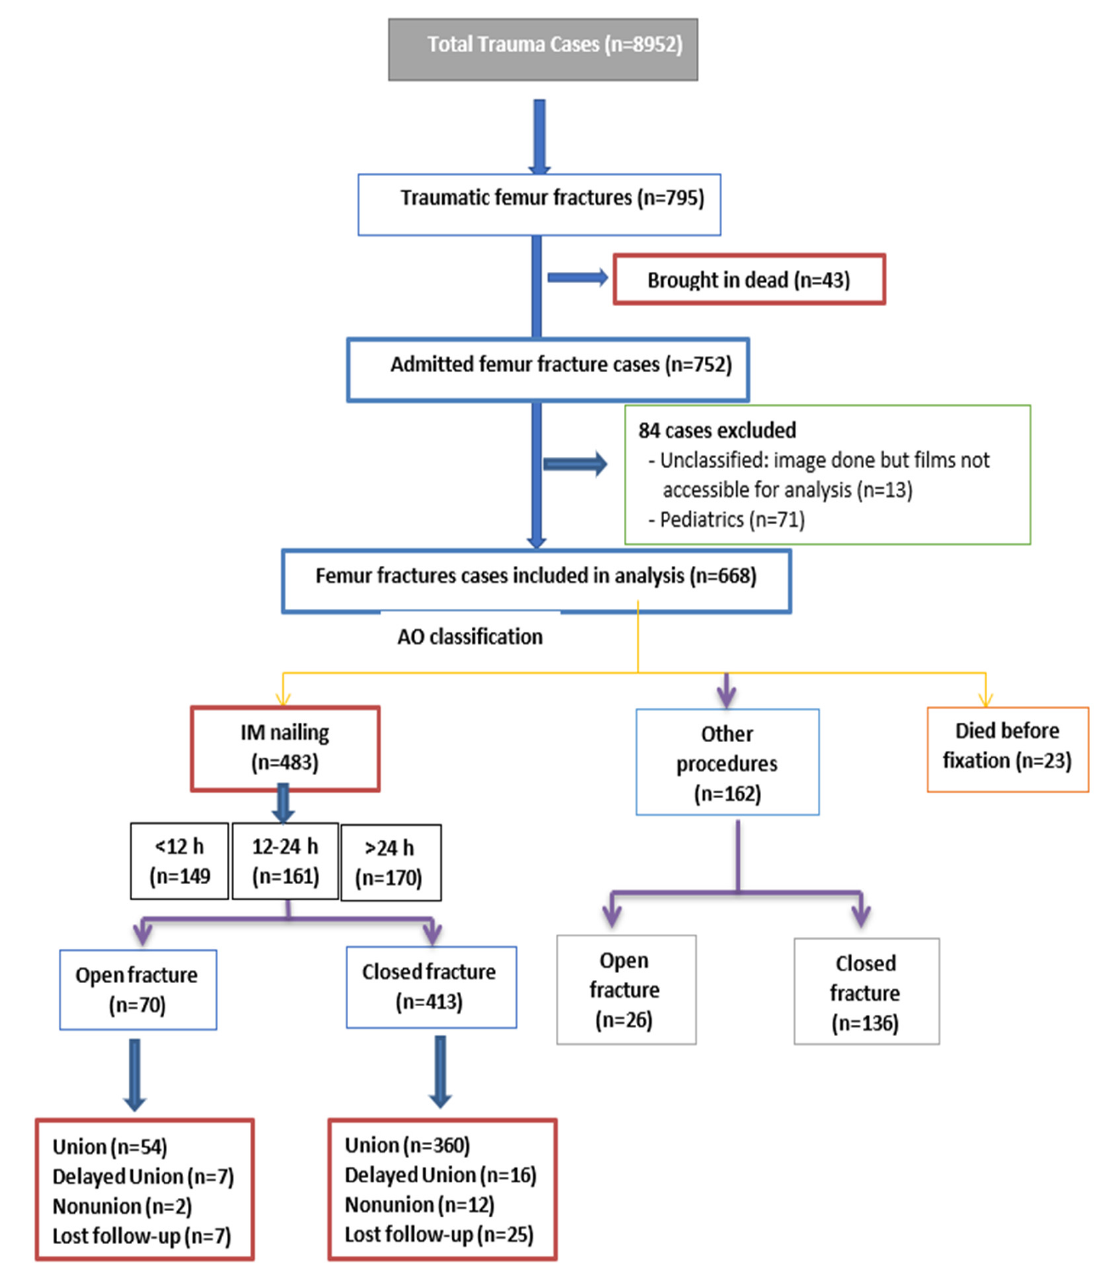
Figure 1. The study design.